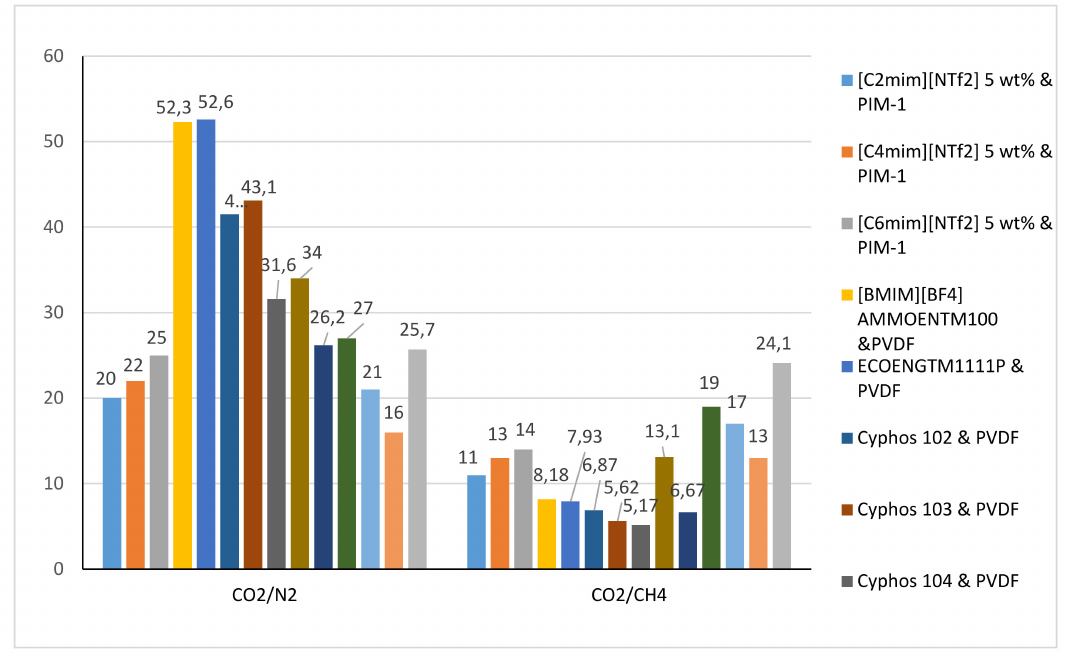
Figure 6. The selectivity of CO 2 / N 2 and CO 2 / CH 4 through several ILPMs